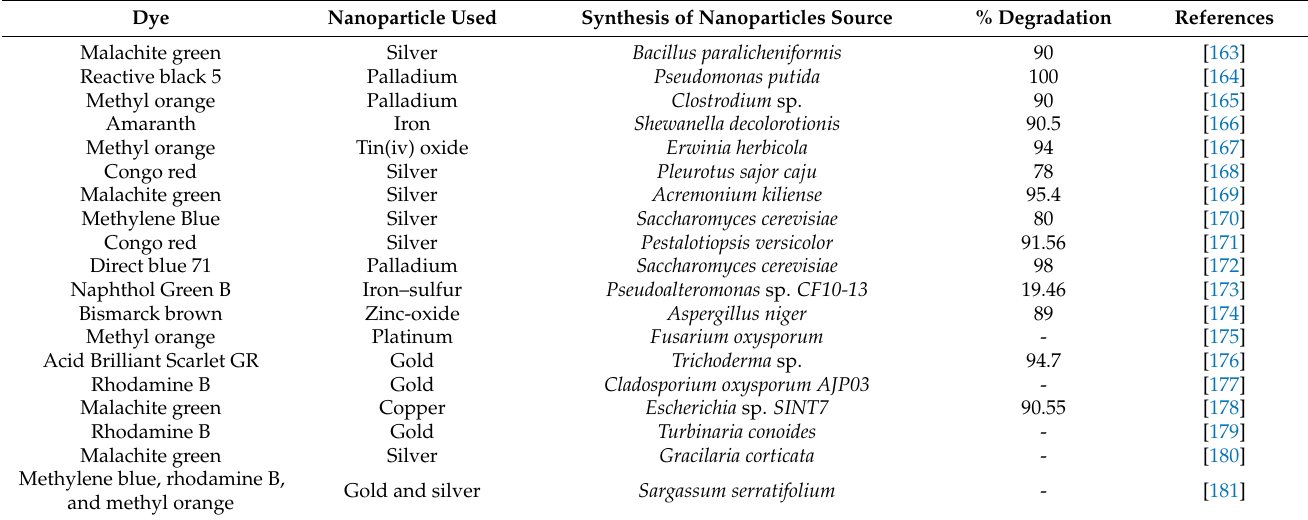
Figure 5. Biological applications of nanocatalyst [162]. Table 4. Degradation of dyes using bacterial-derived